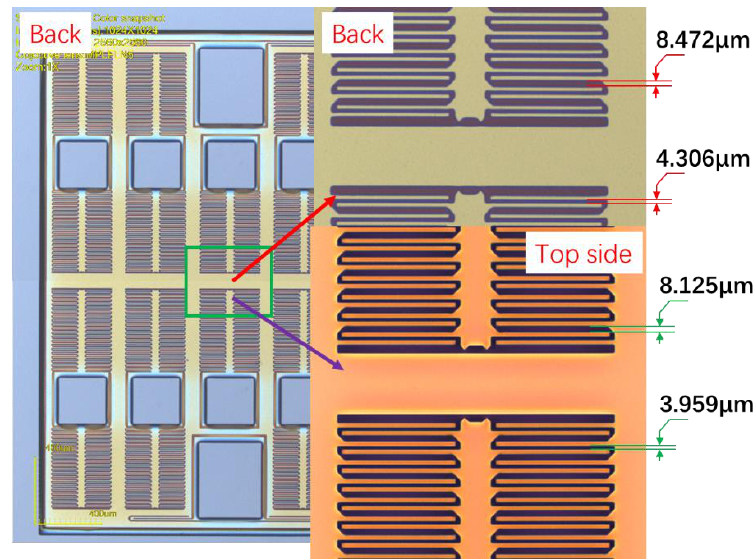
Figure 4. The etched structure.